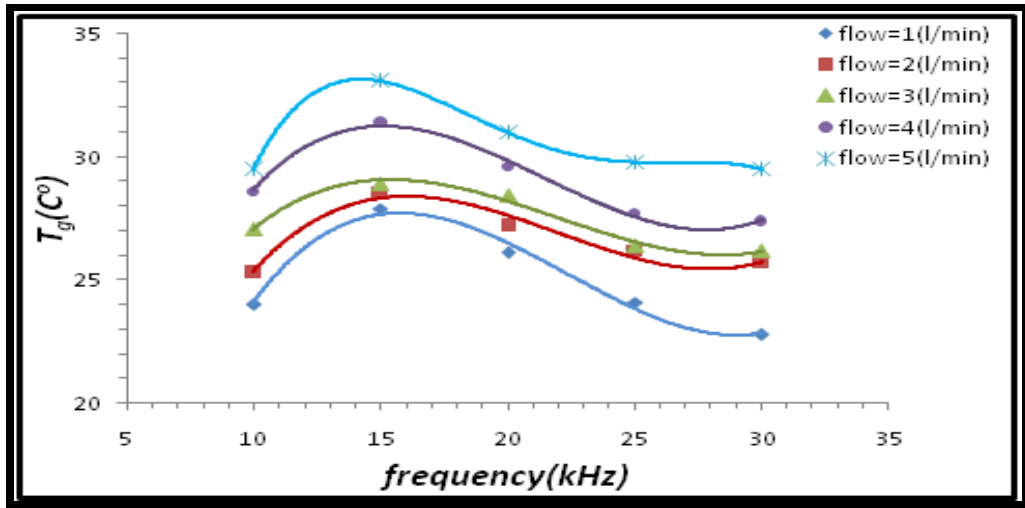
Fig.3: Working gas temperature as a function of frequency for different gas flow rates.